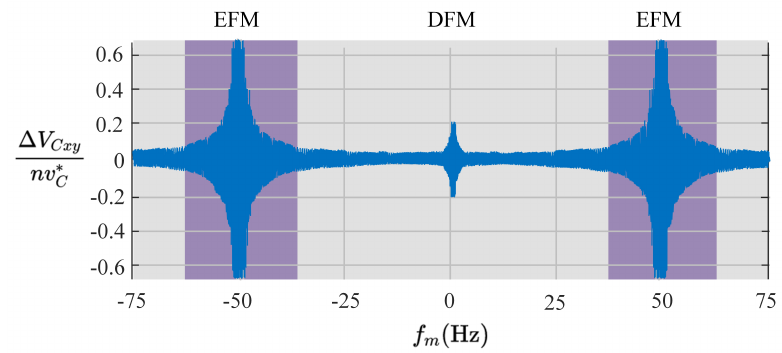
Figure 3. Normalised cluster capacitor voltage (CCV)